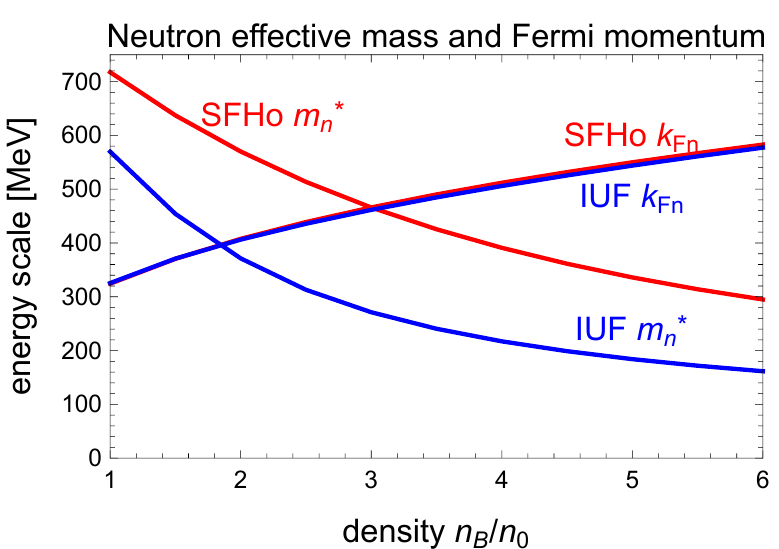
Figure 2. Density dependence of the neutron’s (Dirac) effective mass and Fermi momentum for the IUF and SFHo EoSs, showing that neutrons at the Fermi surface become relativistic at densities above 2 to 3 n 0 .